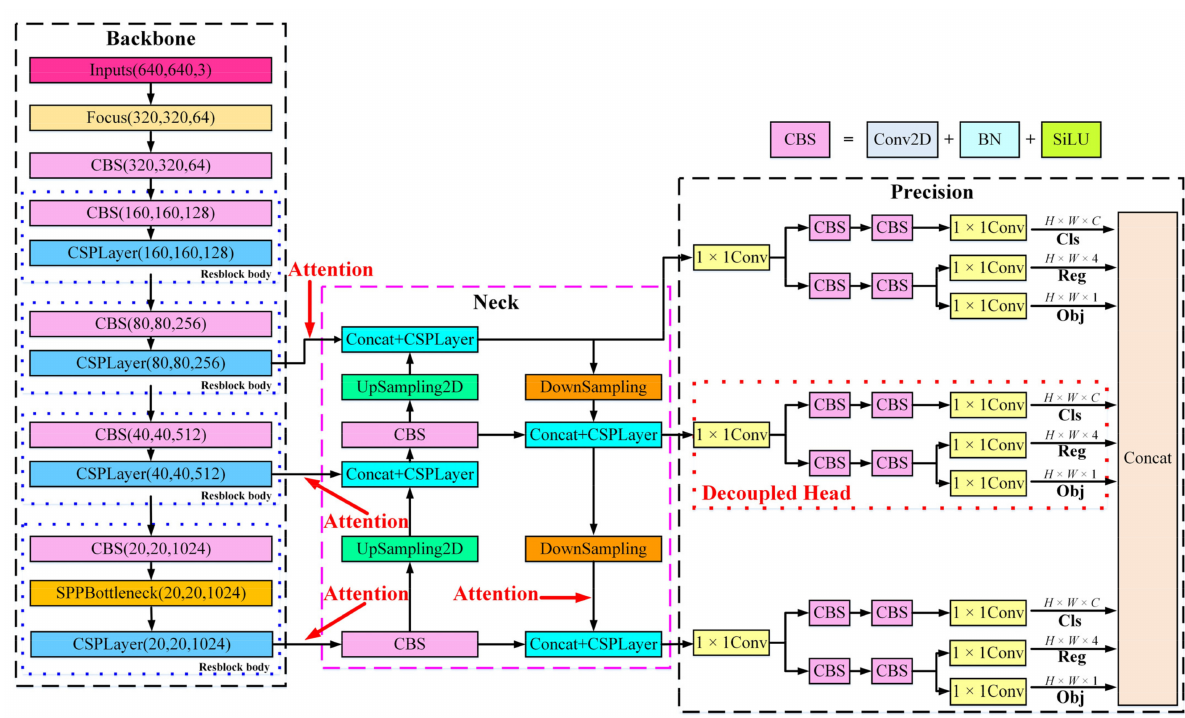
Figure 3. The network structure of improved